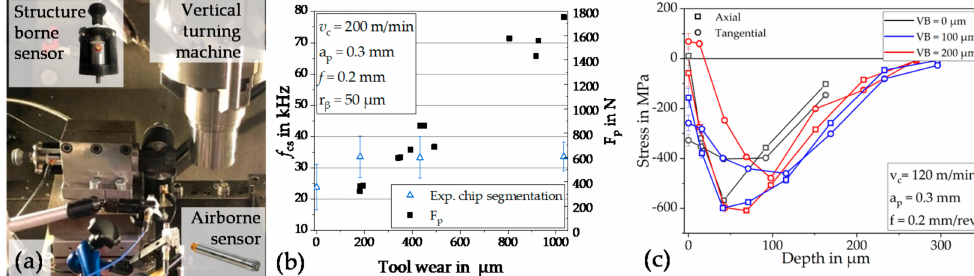
Figure 9. Identification ( a ) Experimental setup; ( b ) correlation between chip segmentation frequency, tool wear and passive forces; ( c ) influence of the tool wear on the residual